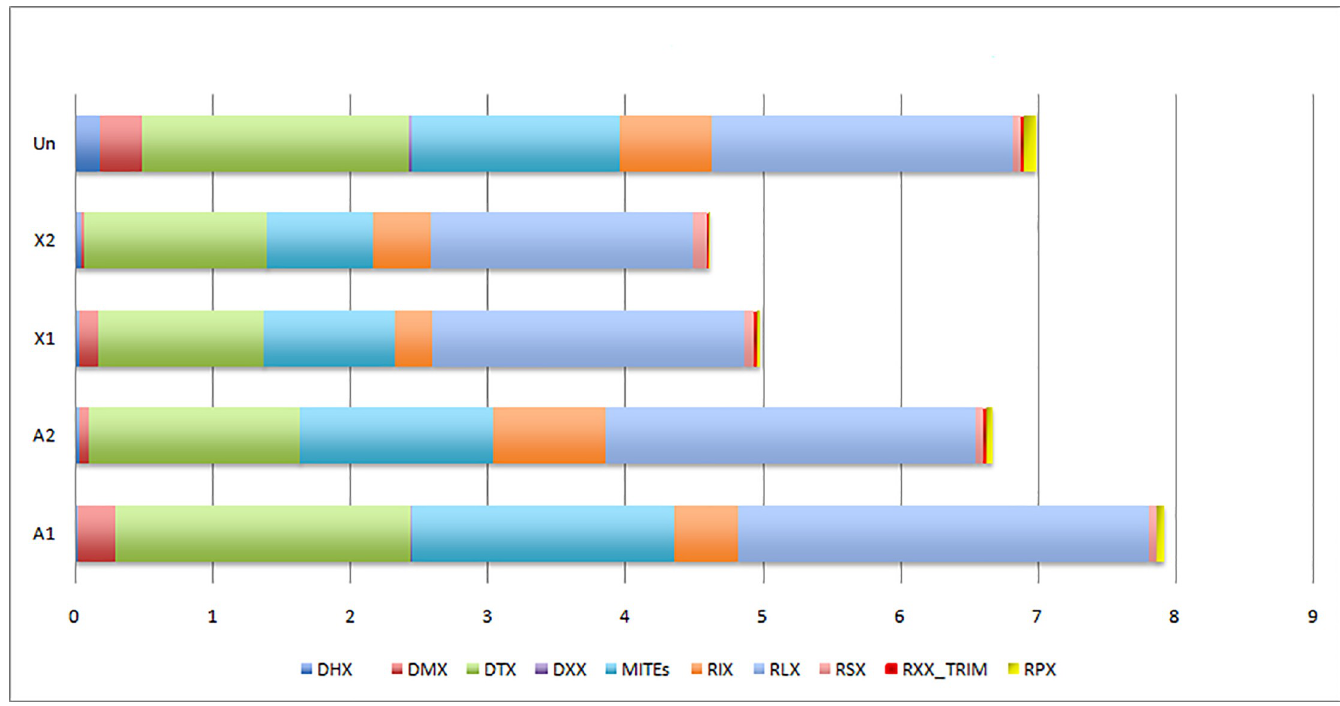
Fig 1. Proportions of TEs in Mayetiola destructor chromosomes. A1 and A2: autosomes. X1 and X2: heterosomes. Un: scaffolds non-anchored to chromosomes (unplaced) are considered as a fifth chromosome. DHX: Helitrons . DMX: Maverick . DTX: TIRs elements. DXX: Other Class II transposons. RIX: LINEs. RLX: LTR retrotransposons. RSX: SINEs. RXX_TRIM: Terminal Repeat Transposons in Miniature. RPX: Penelopes . The x-axis refers to the percentage of TEs per